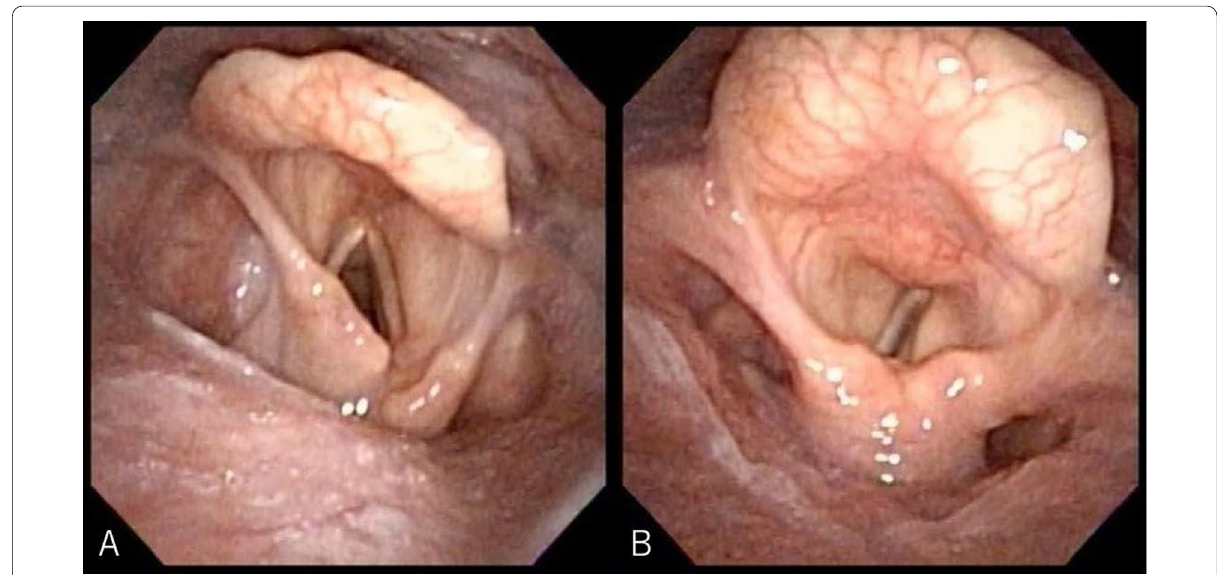
Fig. 3 Case 2: this figure shows laryngoscopic findings during breathing ( A ) and phonation ( B ), showing that the left vocal cord is